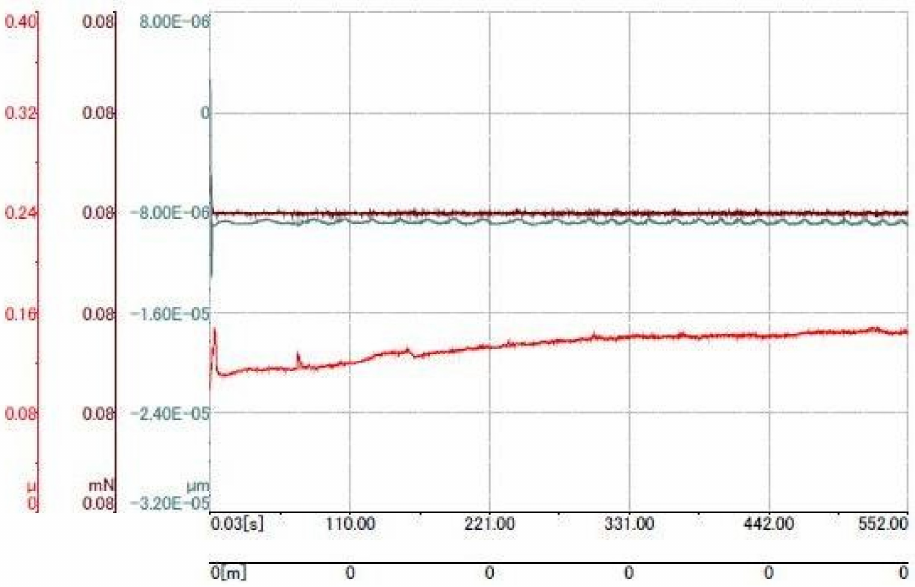
Figure 9. Results of wear tests for the chitosan of DD 94% sigma coating: red color—change in friction coe ffi cient with test time, green color—change in penetration depth ( µ m), and brown color—load force, which was constant during the